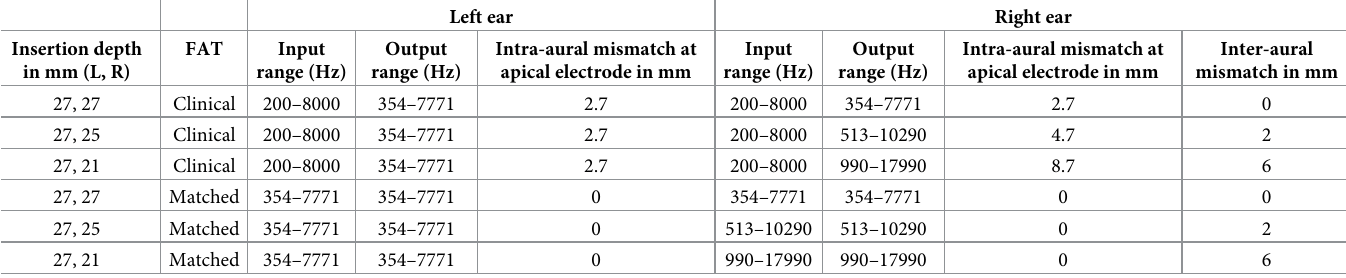
Table 1. Details of the 16-channel sinewave vocoders characteristics, including the simulated insertion depth in each ear, the experimental frequency allocation table (FAT) conditions, the input and output frequency ranges in each ear, the intra-aural mismatch within each ear at the most apical electrode, and the inter- aural mismatch across